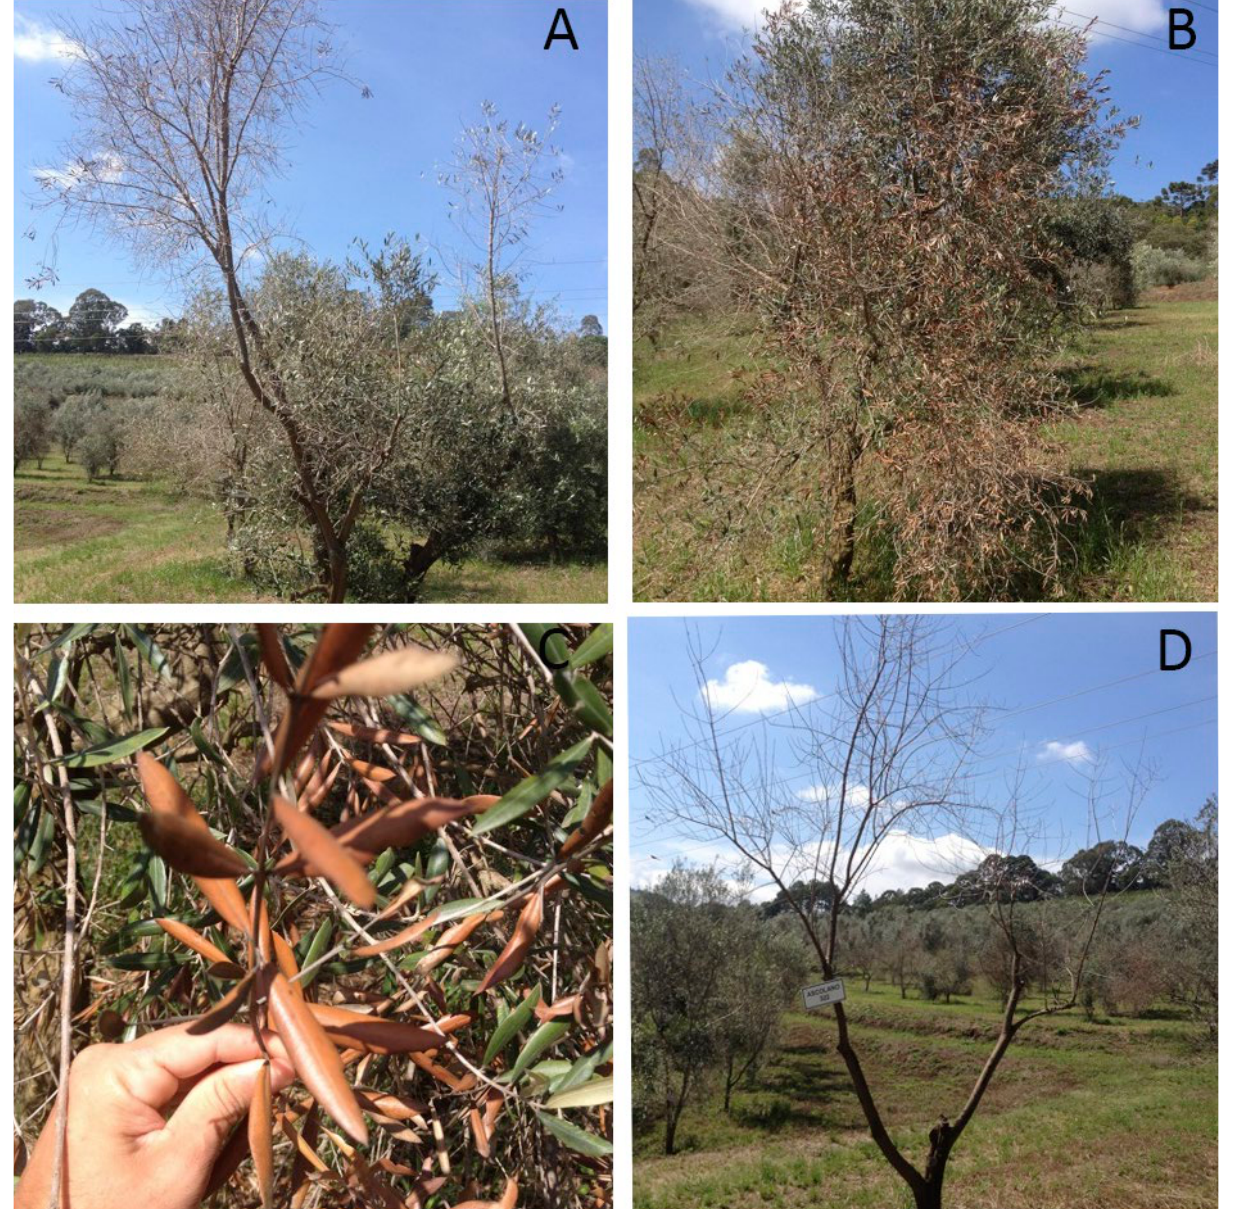
Figure 1. Symptoms observed on olive trees in Maria da Fé, Minas Gerais State, Brazil. A. Leaf drop. B. Leaves showing severe scorching. C. Detail of leaf scorching. D. Plant death and (background) olive trees showing leaf scorching spreading through the